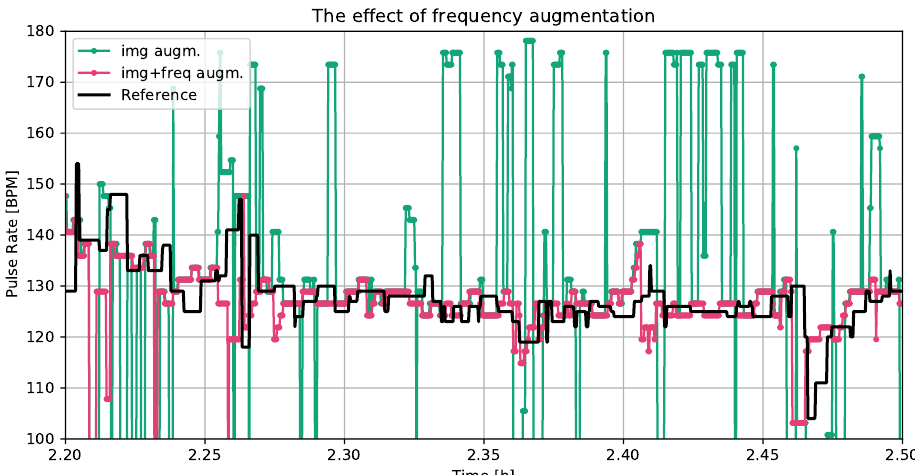
Figure 12. The estimated pulse rates from the output signal of PhysNet model–in the case of classical image augmentation and additional frequency augmentation–and the corresponding reference pulse-rate values on a selected time segment. The training of the model benefits significantly from frequency